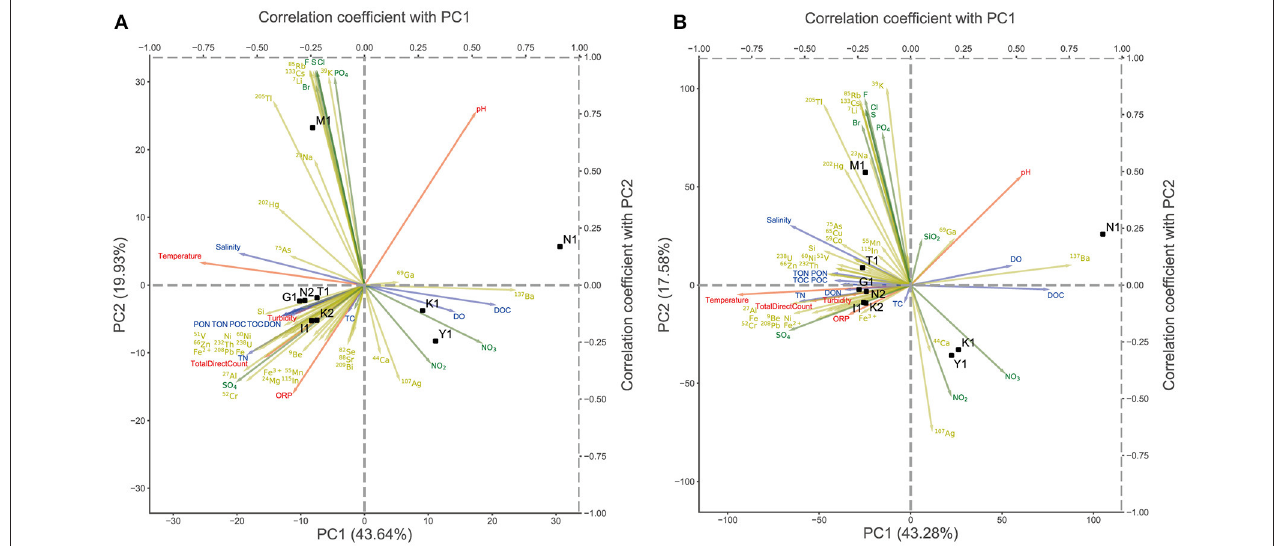
FIGURE 4 | Principal component analysis (PCA) of the abundance of gene categories for each sample across nine sites. The arrows represent the correlation coefficient between the principal component scores and each environmental parameter. The yellow arrows represent cations, the green arrows represent anions, the blue arrows represent water quality and the red arrows represent physical properties. (A) PCA of the KEGG module abundance. (B) PCA of the KEGG Orthology